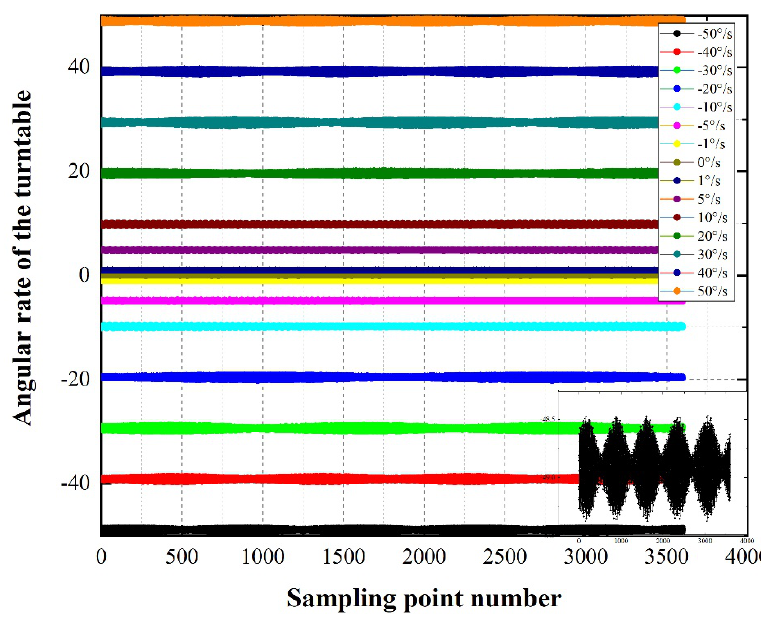
Figure 3. Influence of turntable spindle eccentricity error on FOG 070076 output.